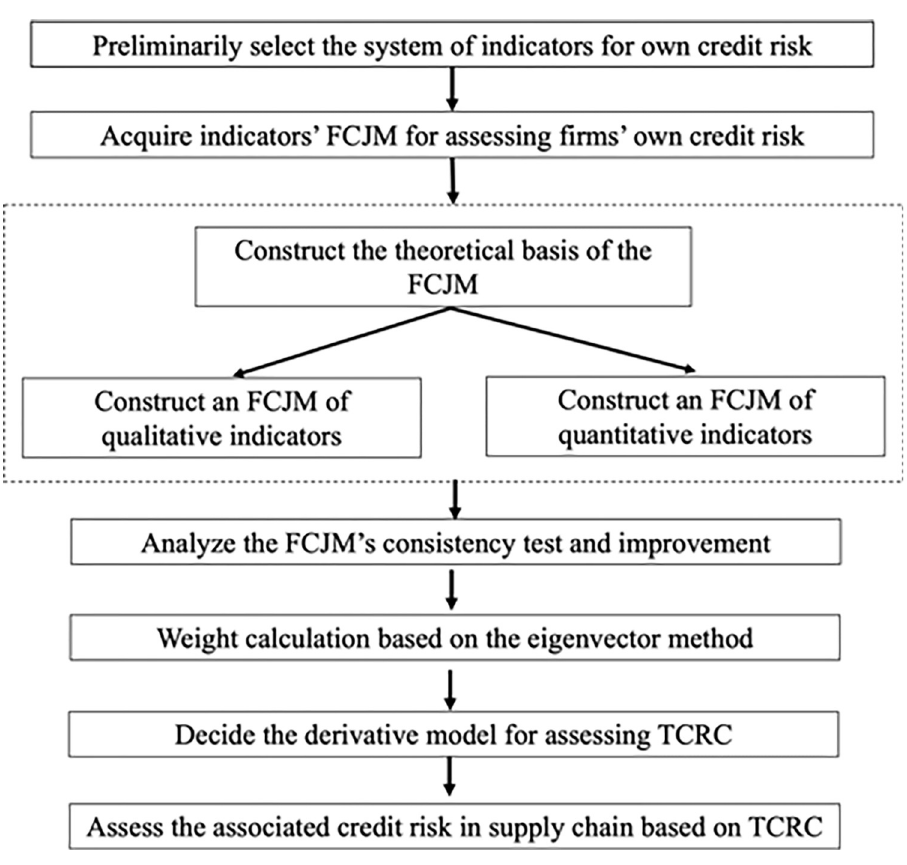
Fig 1. The visual process to evaluate the credit risk of enterprises in the supply